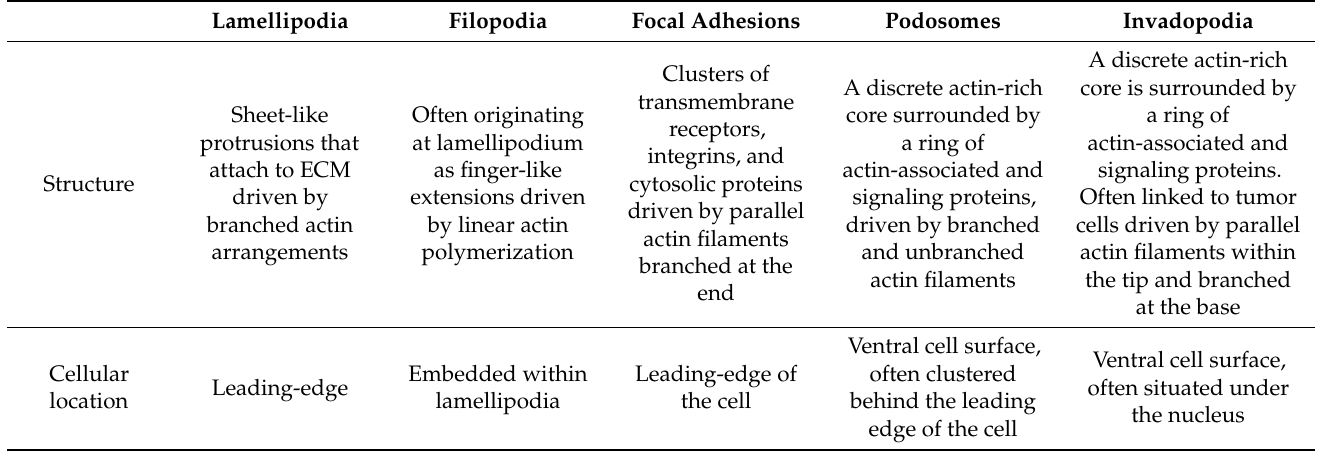
Figure 1. Actin rearrangement in lamellipodia and filopodia. Filopodia emerge from lamellipodium at the leading edge in a cell in movement. Then, actin starts nucleating, helped by specialized proteins such as Arp2/3, GTPases, kinases, and regulators of the actin polymerization such as capping (formin) and anti-capping (Enabled) proteins, these last allowing filament growth, protruding into filopodial extensions. Concomitantly, actin-bundling proteins such as fascin, villin, and α -actinin, bundle actin filaments. Table 1. Adhesive structures, connecting cytoskeleton with ECM, structural and functional differences. Lamellipodia Filopodia Focal Adhesions Podosomes